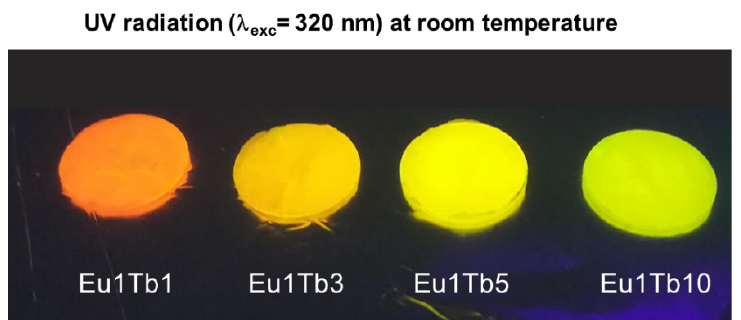
Figure 6. Room temperature Eu-Tb mixed samples appearance under UV irradiation. λ exc = 320 nm.